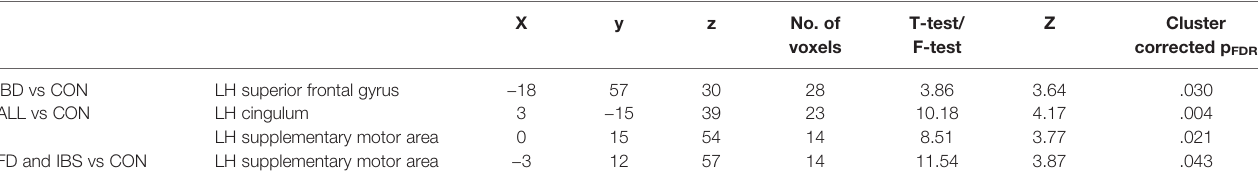
Anatomical labels according to Automated Anatomical Labeling tool. All reported clusters are signi fi cant at cluster p < .05 threshold with topological False Discovery Rate small volume